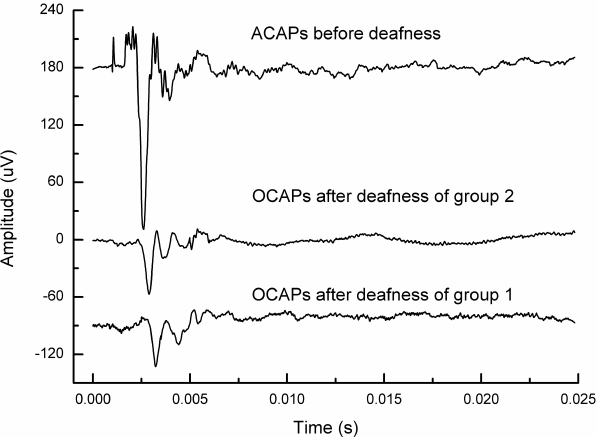
Fig. 4. The upper curve shows ACAPs measured in response to acoustic stimulation before deafness with acoustic tone bursts at 82 dB SPL; The lower two curves show OCAPs measured in response to 465 nm laser stimulation after deaf- ening in both